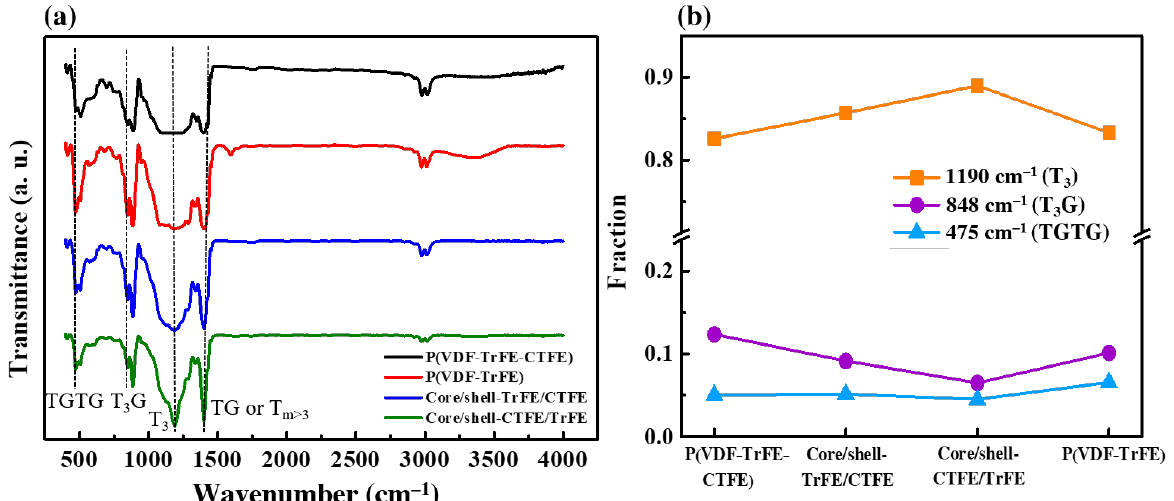
Figure 4. ( a ) FTIR spectra and ( b ) fraction of each chain conformation in the single and coaxial electrospun nanofibers.